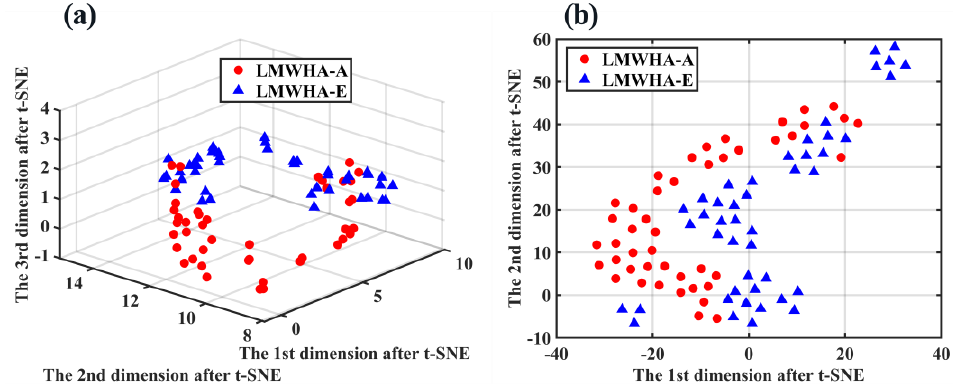
Figure 7. ( a ) Distribution map of LMWHA – A and LWMHA-E in 3D space after t-SNE dimensionality reduction; ( b ) Distribution of LMWHA – A and LWMHA-E in 2D space after t-SNE dimensionality reduction.